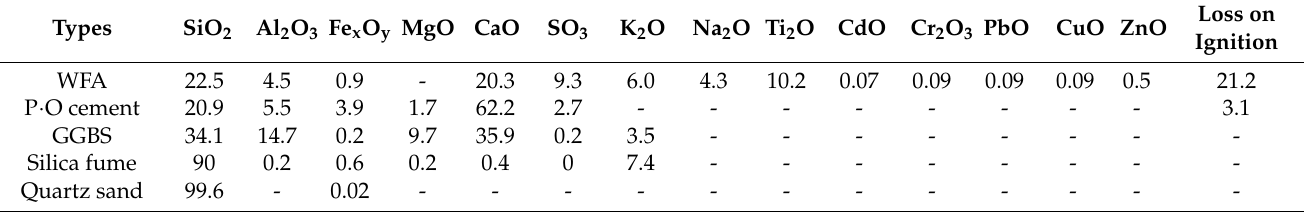
Table 2. Chemical composition (wt.%) of the cementitious materials used in this study.